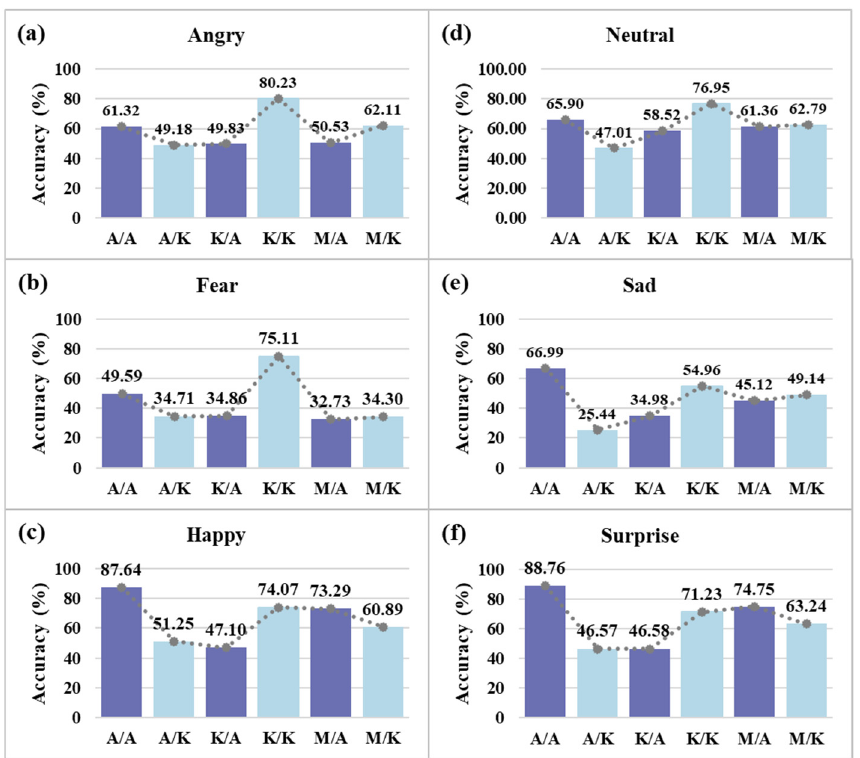
Figure 5. MobileNet-V2’s accuracy according to different emotions: ( a ) angry, ( b ) fear, ( c ) happy, ( d ) neutral, ( e ) sad, ( f ) surprise.